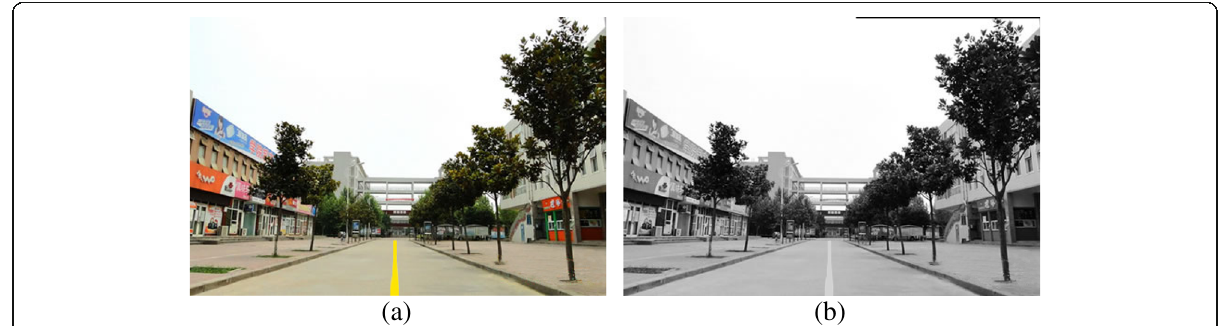
Fig. 2 Gray equalization image of road images. a The original image. b Gray level image after